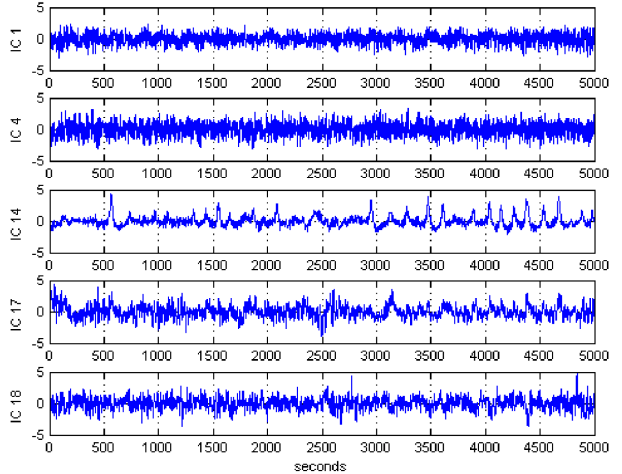
Figure 7. Artifactual components successfully detected by skewness for the first control subject.